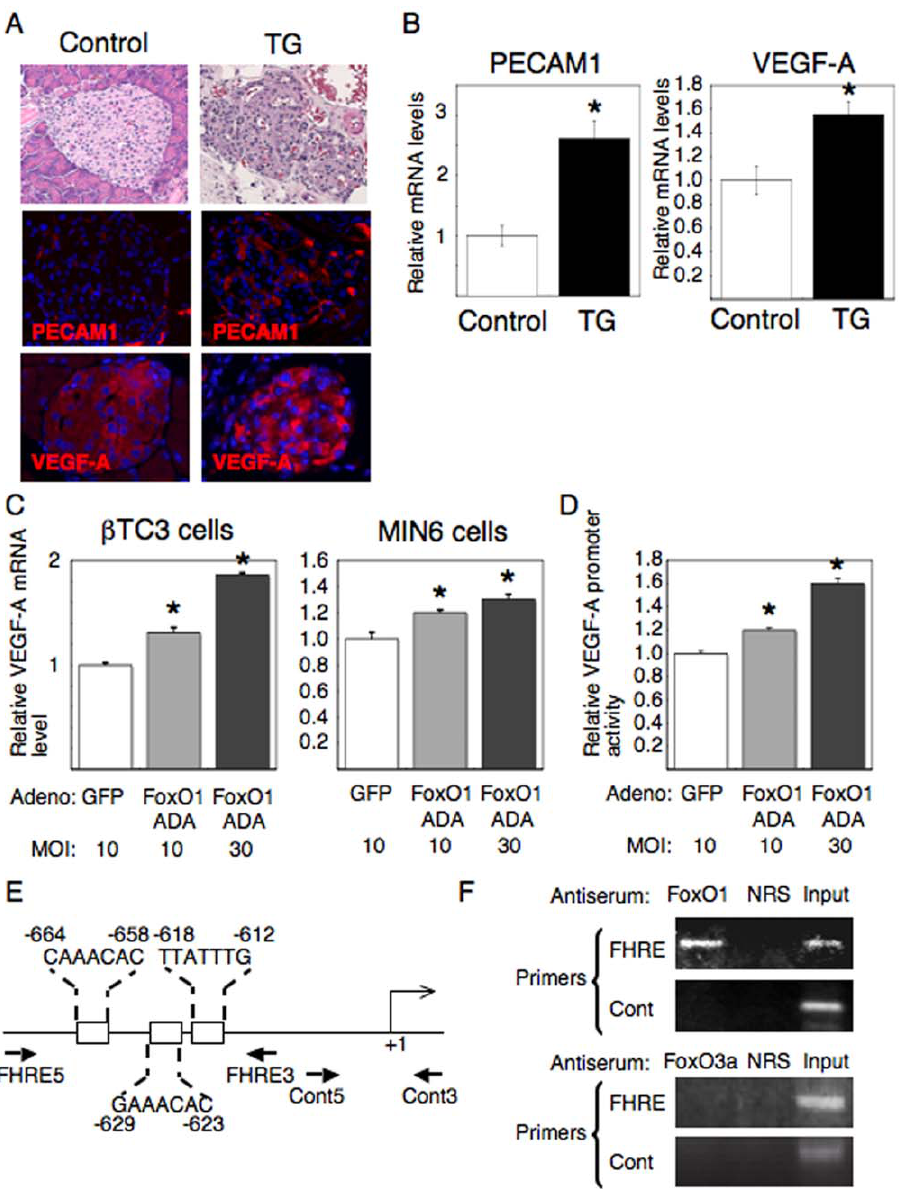
Figure 4. Islet vasculature and VEGF-A expression in b cells are increased in TG mice via FoxO1 regulation of VEGF-A transcription. (A) Hematoxylin and eosin (HE) staining and immunohistochemistry with anti-PECAM1 or anti-VEGF-A antibodies in pancreatic sections from 2 month old TG and control mice. Representative images are shown. (B) Islets were isolated from TG and control mice and used for analyses by real-time RT- PCR to quantify PECAM1 and VEGF-A mRNA levels. In each experiment (A and B), six male and six female mice were analyzed for each genotype. There was no difference between male and female mice. Data represent the mean 6 SEM fold-increase relative to control mice. An asterisk indicates P , 0.05 by ANOVA. (C) b TC3 or MIN6 cells were infected with adenoviruses expressing FoxO1 ADA or GFP at indicated MOI, 24 hrs later mRNA was isolated from the cells and used for real-time RT-PCR to quantify VEGF-A mRNA levels. The results of (B) and (C) were normalized using GAPDH. (D) VEGF-A promoter driven luciferase activities were measured in MIN6 cells infected with adenoviruses expressing FoxO1 ADA or GFP at indicated MOI. For (C) and (D), data represent the mean 6 SEM fold-increase relative to GFP infection. An asterisk indicates P , 0.05 by ANOVA. (E) The promoter region of the mouse VEGF-A gene. Square indicates the location of the forkhead responsive element (FHRE). For ChIP assays, a primer set spanning three FHREs and control primers were used. An arrow indicates the initiation site of RNA synthesis and is designated + 1. (F) ChIP assays of the VEGF-A promoter are shown. We performed ChIP assays in MIN6 cells with indicated antisera. NRS indicates normal rabbit serum used as a control antisera. The crosslinked DNA was amplified by PCR using FHRE and Cont primers. Input represents DNA extracted from chromatin prior to immunoprecipitation. We used input DNA with 1:100 dilution. doi:10.1371/journal.pone.0032249.g004 were b cells, but not a cells, by double staining VEGF-A with showed that both PECAM1 and VEGF-A were significantly insulin or glucagon (Fig. 5). To quantify these results, we increased in TG islets compared to control islets (Fig. 4B and 5B), performed real-time RT-PCR and densitometry analysis, and despite that the number of b cells were decreased in TG islets